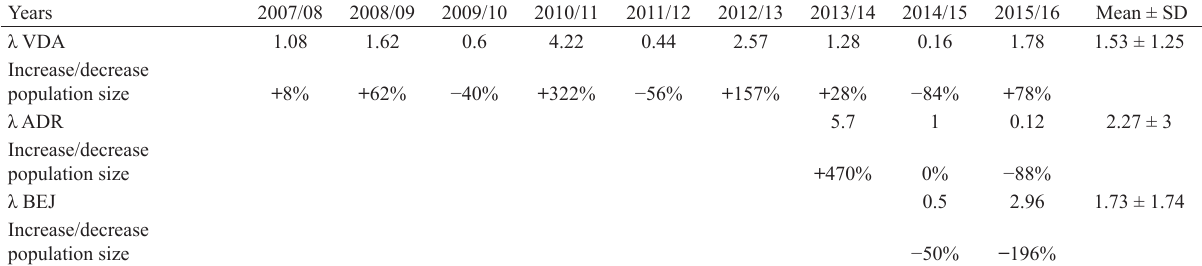
Table 4. Finite rates of population growth calculated for the subpopulations of Villarino de los Aires (VDA), Aldeadávila de la Ribera (ADR) and Béjar